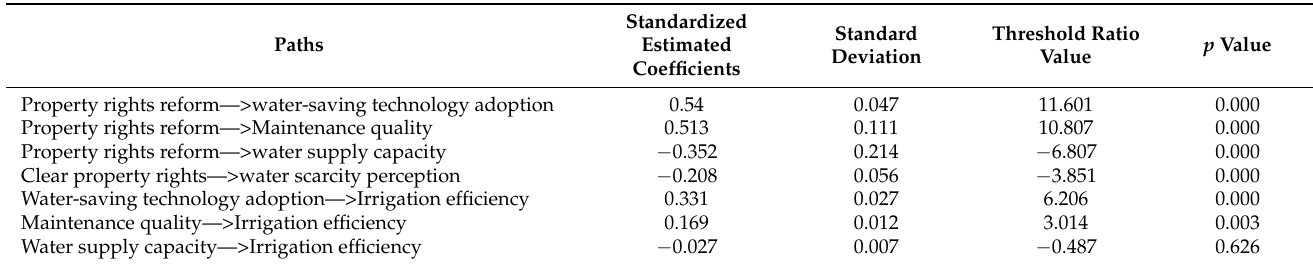
Figure 6. Pathways of the effect of property rights reform of farmland water facilities on irrigation efficiency. Note: Solid arrows indicate significant paths of action, and dashed arrows indicate insignificant paths of action; values next to arrows are path coefficients; *** represent significance at the 1% statistical level. Table 9. Standardized regression coefficient results of the path analysis of the impact of property rights reform on the irrigation efficiency of farmland water